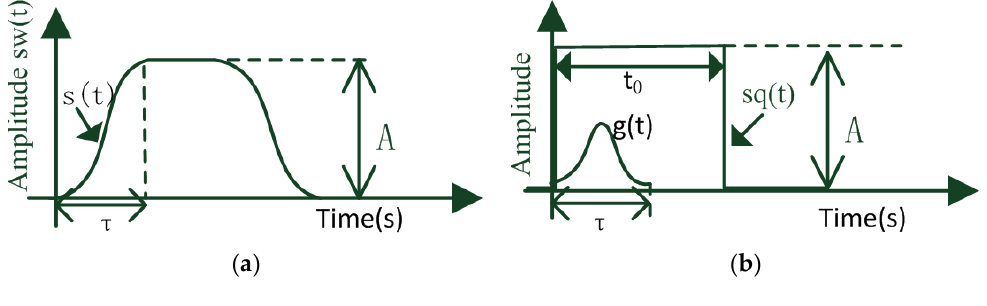
Figure 1. Switching signal ( a ) and structure ( b ).